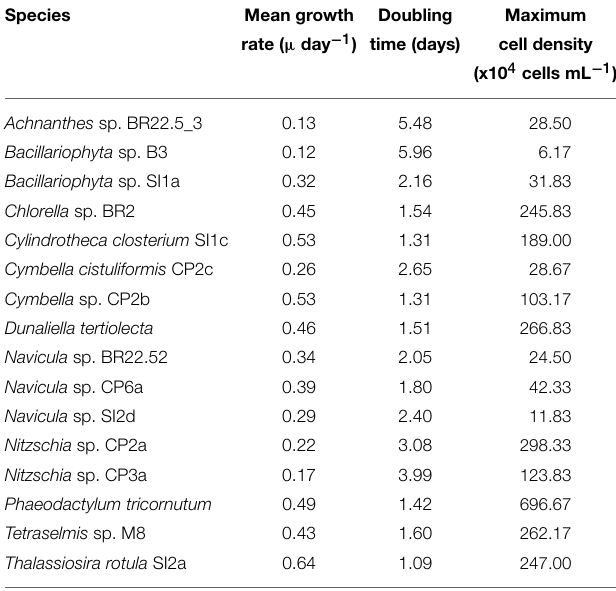
TABLE 2 | Growth characteristics of the isolated strains in f/2 medium during the duration of the standard assay.